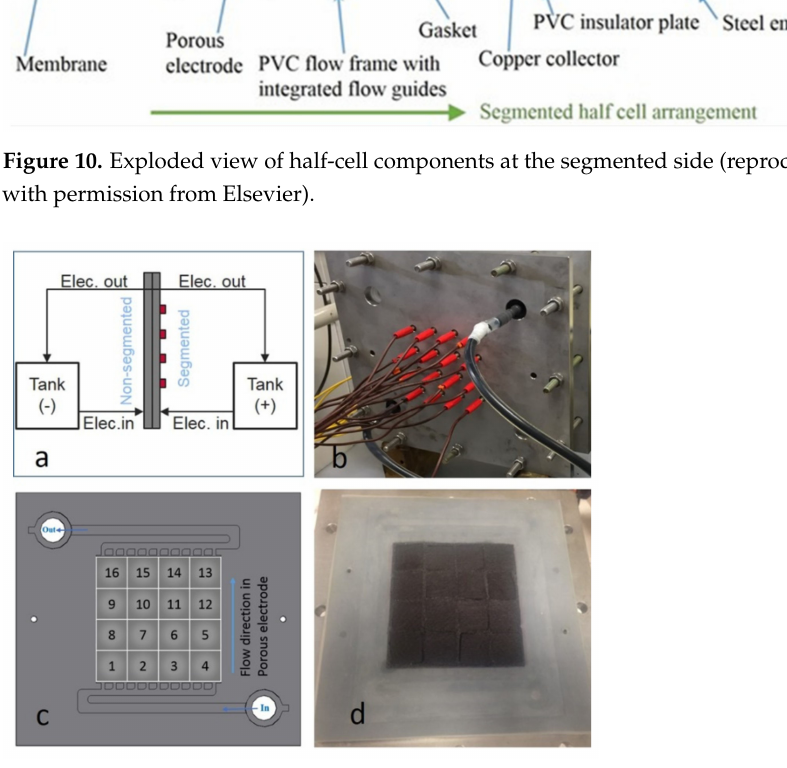
Figure 11. Experimental set up ( a ), positive segment side with 16 cables with electrolyte inlet and outlet ( b ), arrangement of the segments showing electrolyte flow direction ( c ) arrangement of cell with 16 segmented and insulating frame on the flow frame ( d ) (reproduced from ref [101], with permission from